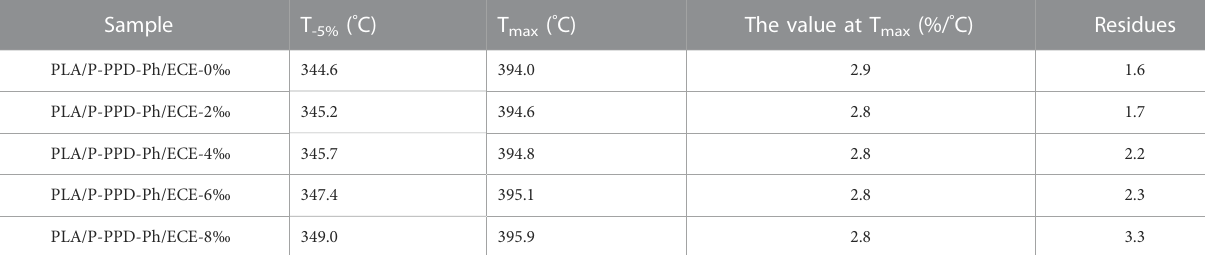
TABLE 1 TGA and DTG data for PLA/P-PPD-Ph/ECE conjugated fl ame retardant composites. Sample